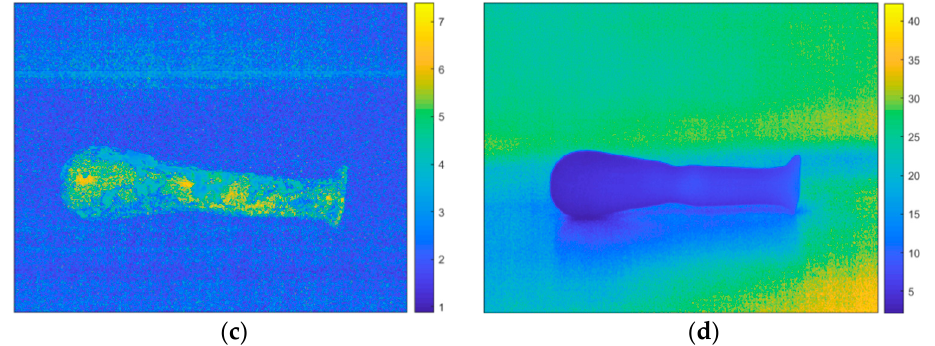
Figure 4. Kurtograms of the sample 1462 with different excitation pulse: ( a ) flash lamps with white diffuser, ( b ) flash lamps with blue filter, ( c ) flash lamps with red filter and ( d ) square pulse with halogen